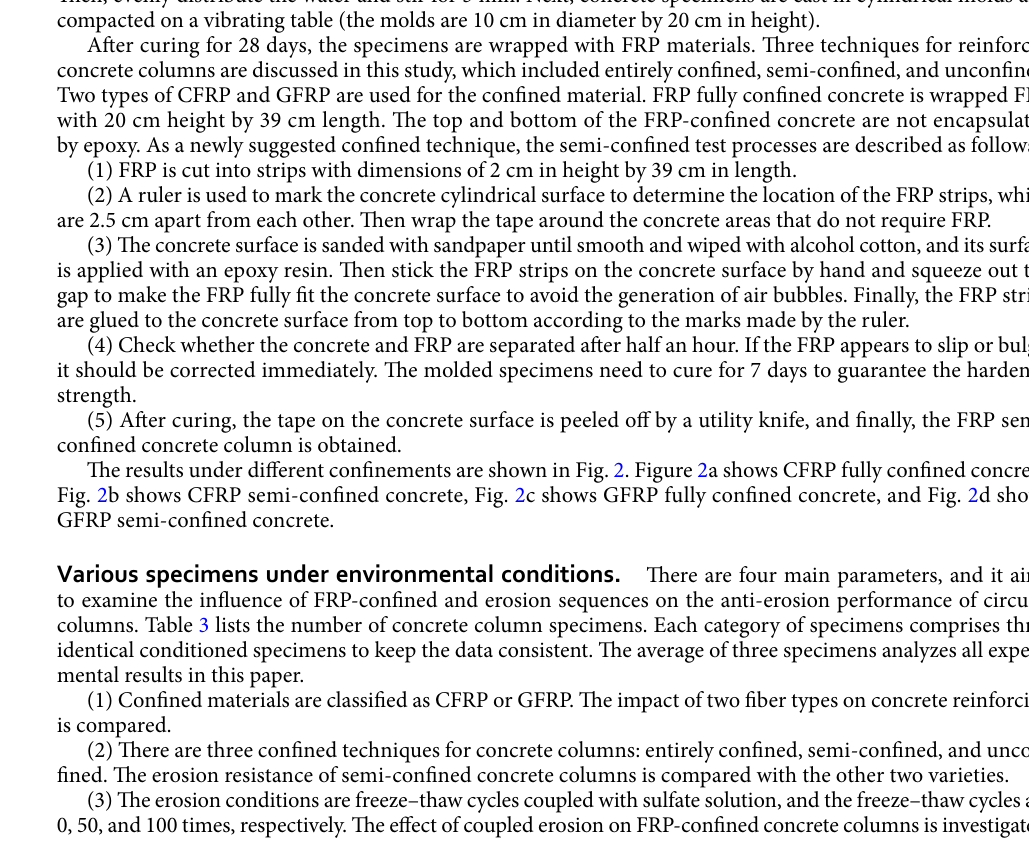
Table 2. Concrete mix ratio and grade.